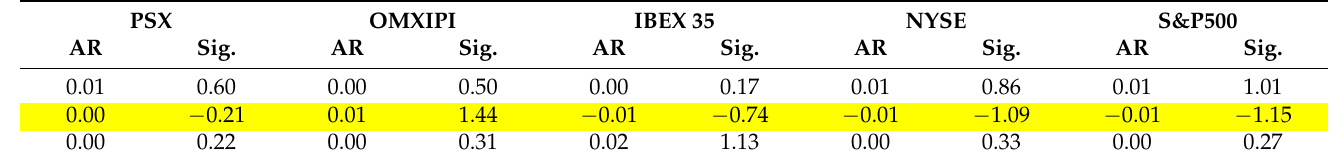
Table A27. Abnormal returns of the ( − 1, +1) event window (Jurgen Mossack Resignation).